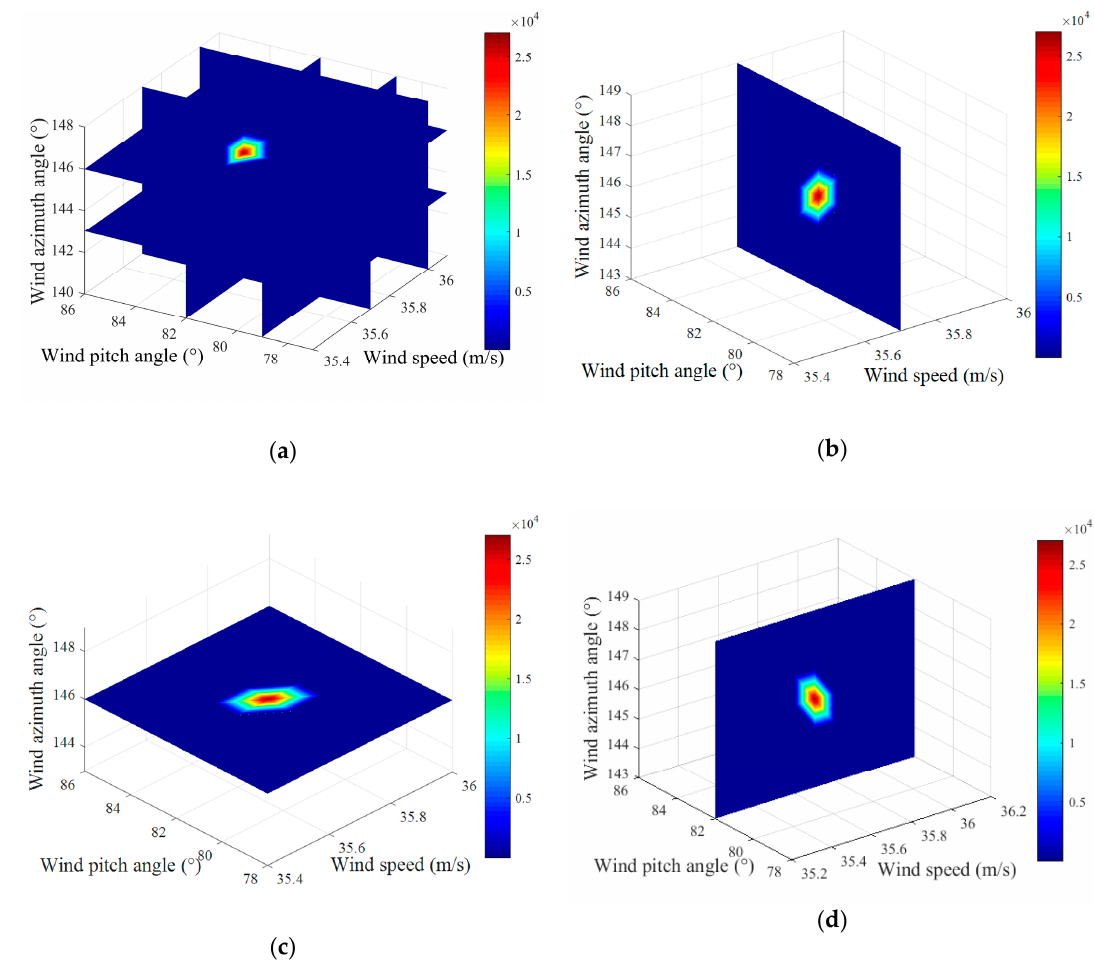
Figure 3. Result of the spectral peak searching: ( a ) result of peak searching, ( b ) the slice result in the direction of wind speed, ( c ) the slice result in the direction of wind azimuth angle, and ( d ) the slice result in the direction of wind pitch angle.